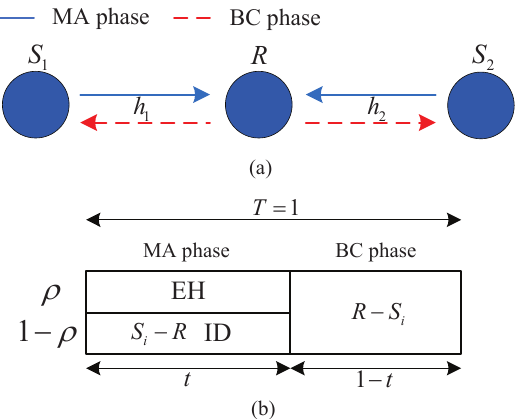
Figure 1. EH-TWR Network System Model and Transmission Structure with Power Splitting Protocol. ( a ) System model; ( b ) power splitting simultaneous wireless information and power transfer (PS-SWIPT) for decode-and-forward two-way relay (DF-TWR)